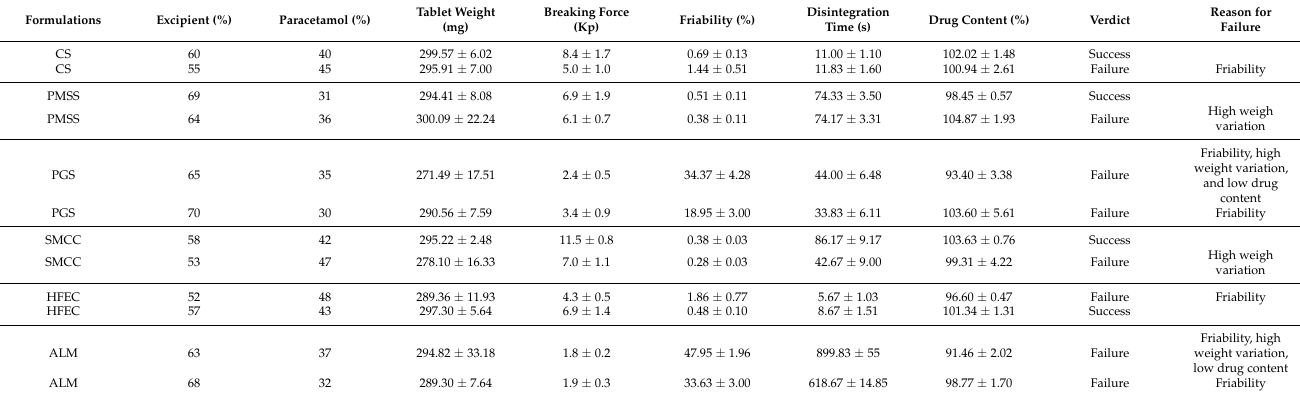
Table 5. Properties of paracetamol tablets formulated with various types and ratios of